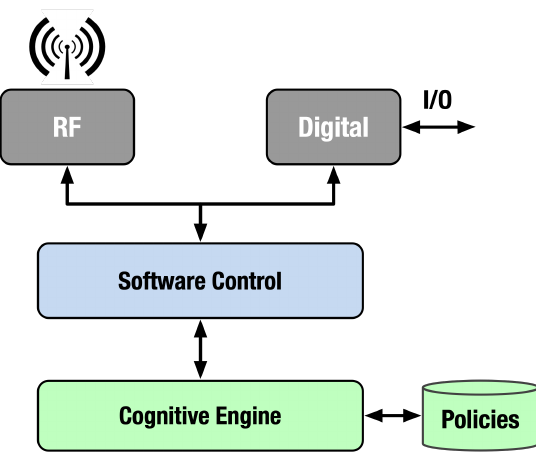
Figure 2. Cognitive radio—top